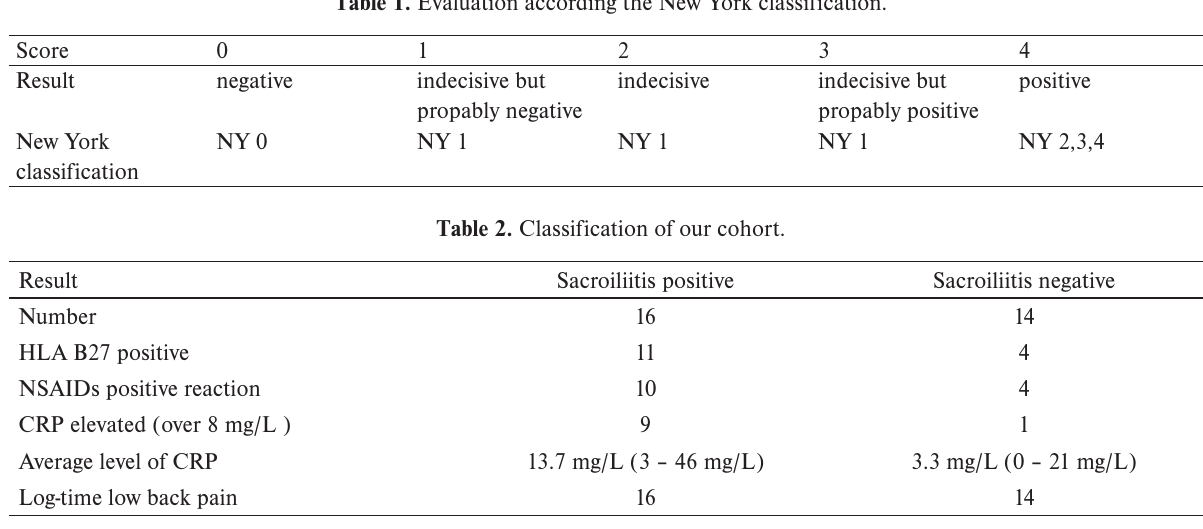
Table 1. Evaluation according the New York classification.